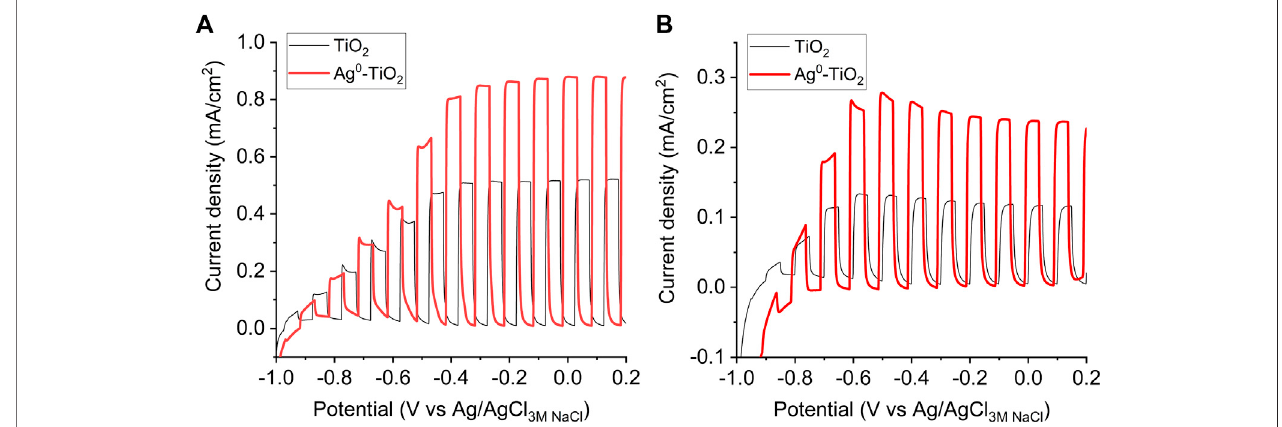
FIGURE 2 | Photoelectrochemical activity of TiO 2 and Ag 0 -TiO 2 fi lms in 0.1 M Na 2 SO 4 with 5 v/v% methanol aqueous solution. Photovoltammograms recorded using solar simulator (A) and Hg − Xe arc-lamp (B) irradiation at a scan rate of 5 mV/s.